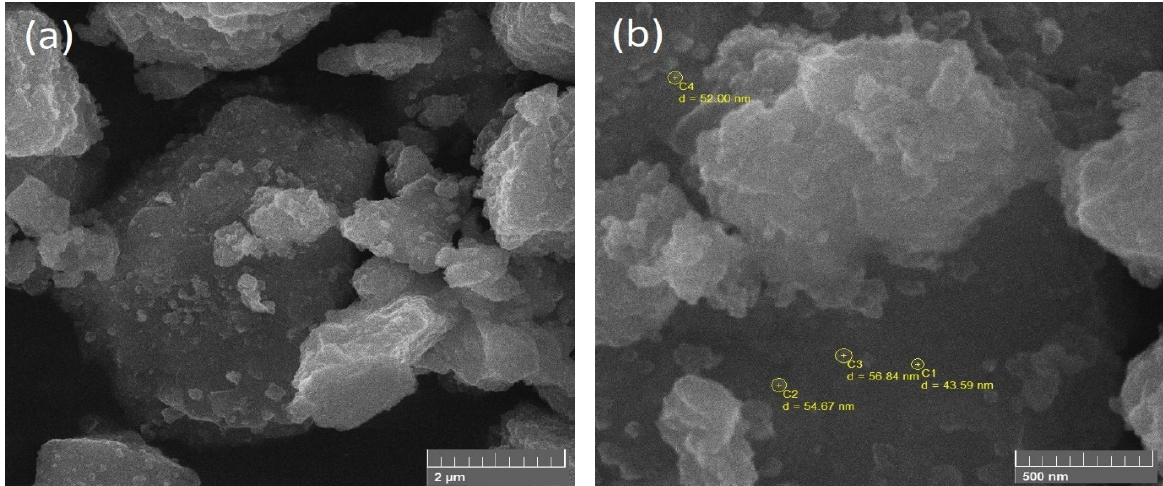
Figure 2. SEM Images of NiFe nanoparticles on ( a ) low and ( b ) high resolution.